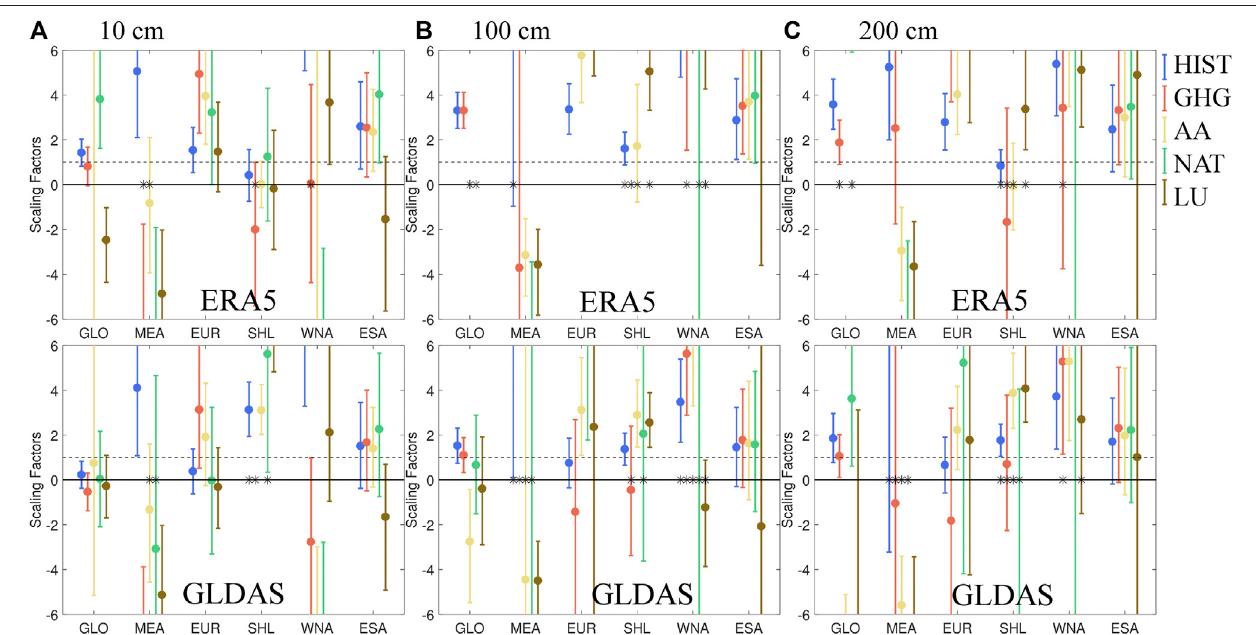
FIGURE5| Scaling factors throughthe optimal fi ngerprint method overglobalaverage(GLO),mid-latitudesofEast Asia(MEA), Europe (EUR),AfricanSahel(SHL), Western North America (WNA), and Eastern South America (ESA). The blue dot is the scaling factor of the all forcing (HIST) signal, the red dot is the scaling factor of the greenhousegase(GHG)forcingsignal,theyellowdotisthescalingfactoroftheanthropogenicaerosol(AA)forcingsignal,thegreendotisthescalingfactorofthenatural (NAT)forcingsignal,andthebrowndotisthescalingfactorofthelanduse(LU)forcingsignal.Thecorrespondingextensionlineisthe90%con fi denceintervalofthe scaling factor. (A) , (B) , and (C) Shallow (10 cm), middle (100 cm), and deep (200 cm) soil moisture, respectively.